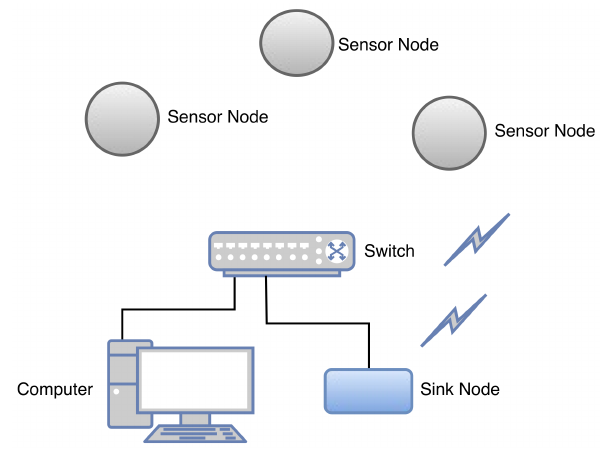
Figure 5. WSN topology and